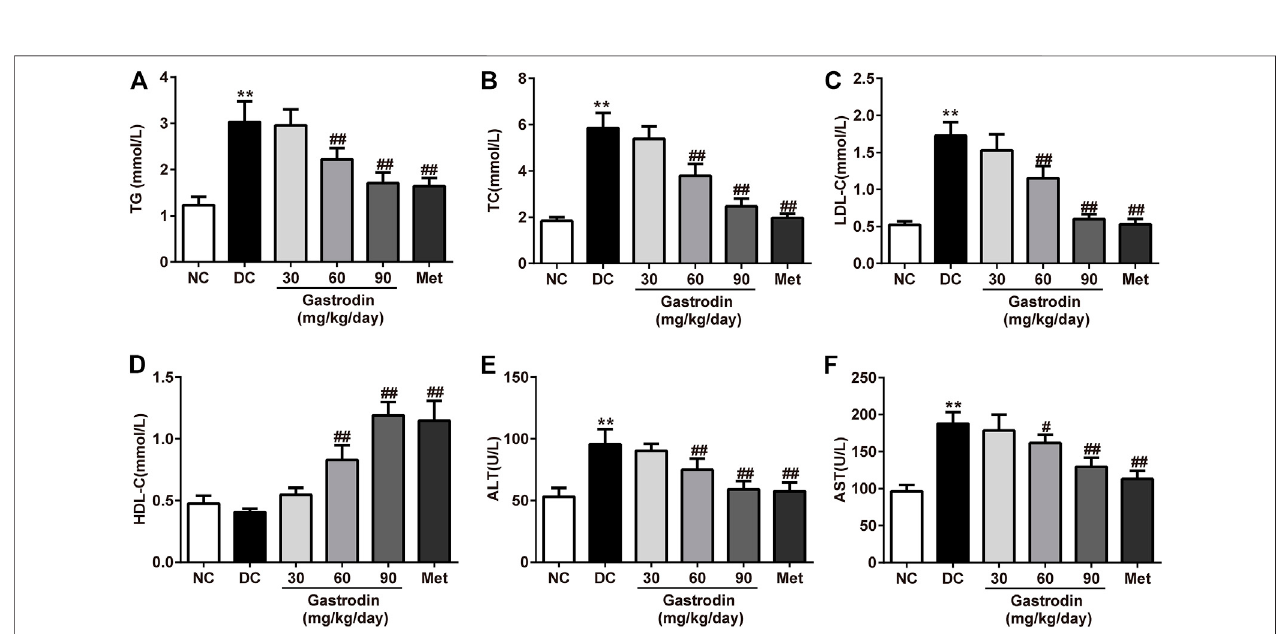
FIGURE3| TheeffectsofGastrodinonserumlipidpro fi les.EffectsofGastrodinontheTG (A) ,TC (B) ,LDLcholesterol (C) ,HDLcholesterol (D) ,ALTandASTlevels in T2DM rats. The results were presented as mean ± SD ( n (cid:1) 6). ** p < 0.01, vs. NC group, # p < 0.05, ## p < 0.01, vs. DC group.